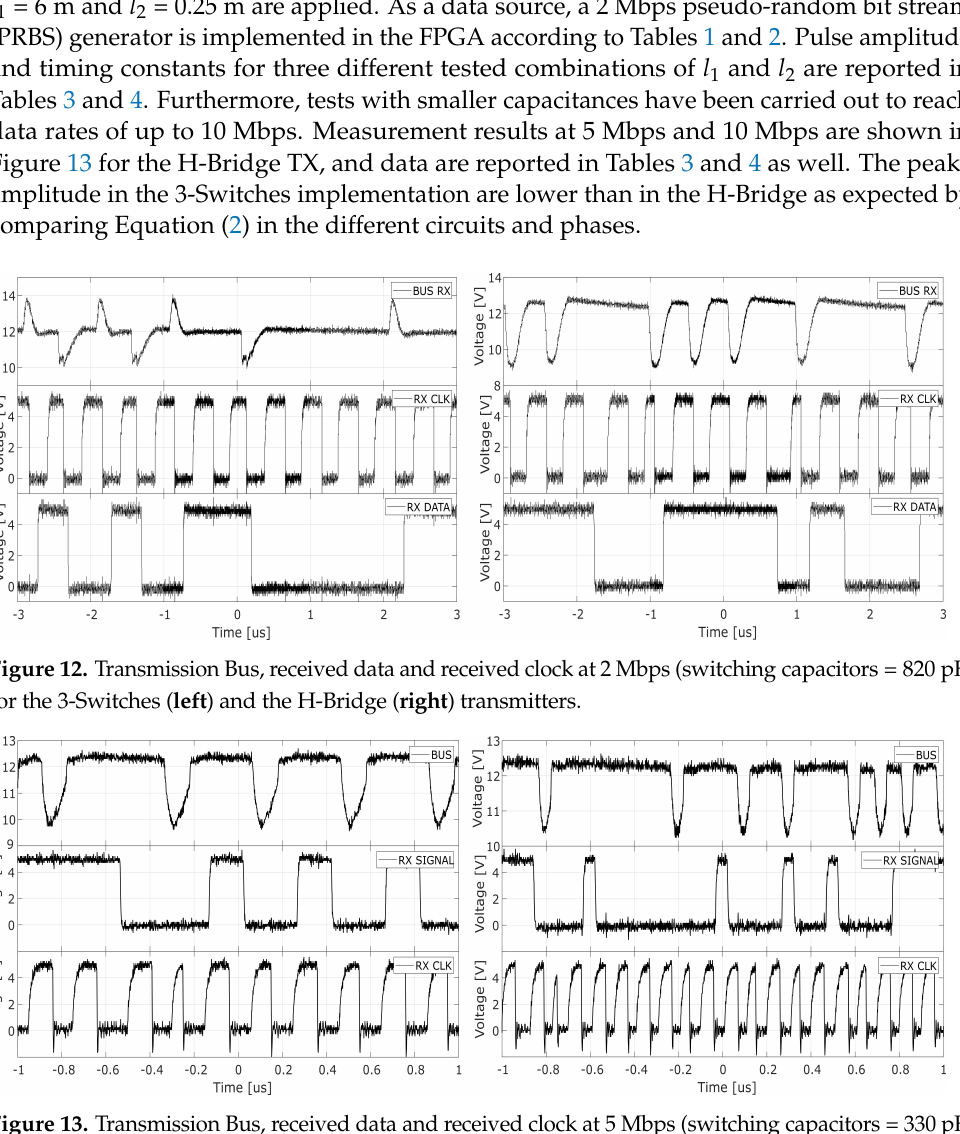
Figure 13. Transmission Bus, received data and received clock at 5 Mbps (switching capacitors = 330 pF) and 10 Mbps (switching capacitors = 180 pF) for the H-Bridge